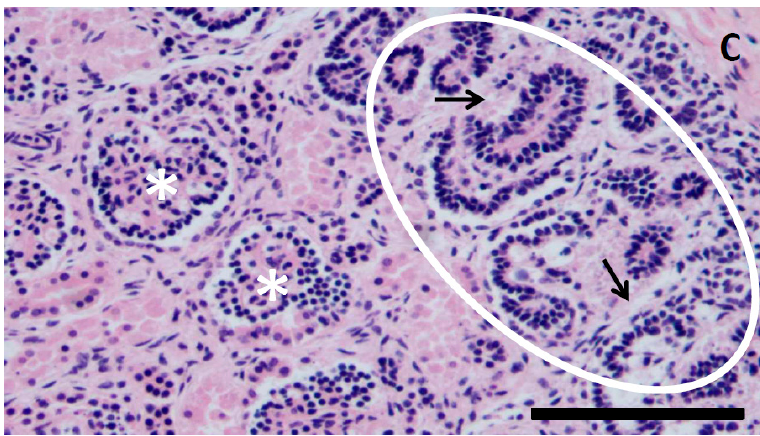
Figure 1. Kidney of a stillborn fetus with intrauterine growth restriction at 22 weeks of gestation. Note subcapsular (C) nephrogenic zone (encircled) with proliferating tubules (black arrows). Immature bilobed glomeruli (asterisks) lined by epithelial cells. Magnification 200×, hematoxylin-eosin staining. Scale bar 100 um. Courtesy: Dr. Jouko Lohi, Department of Pathology, Helsinki University Hospital, Finland.